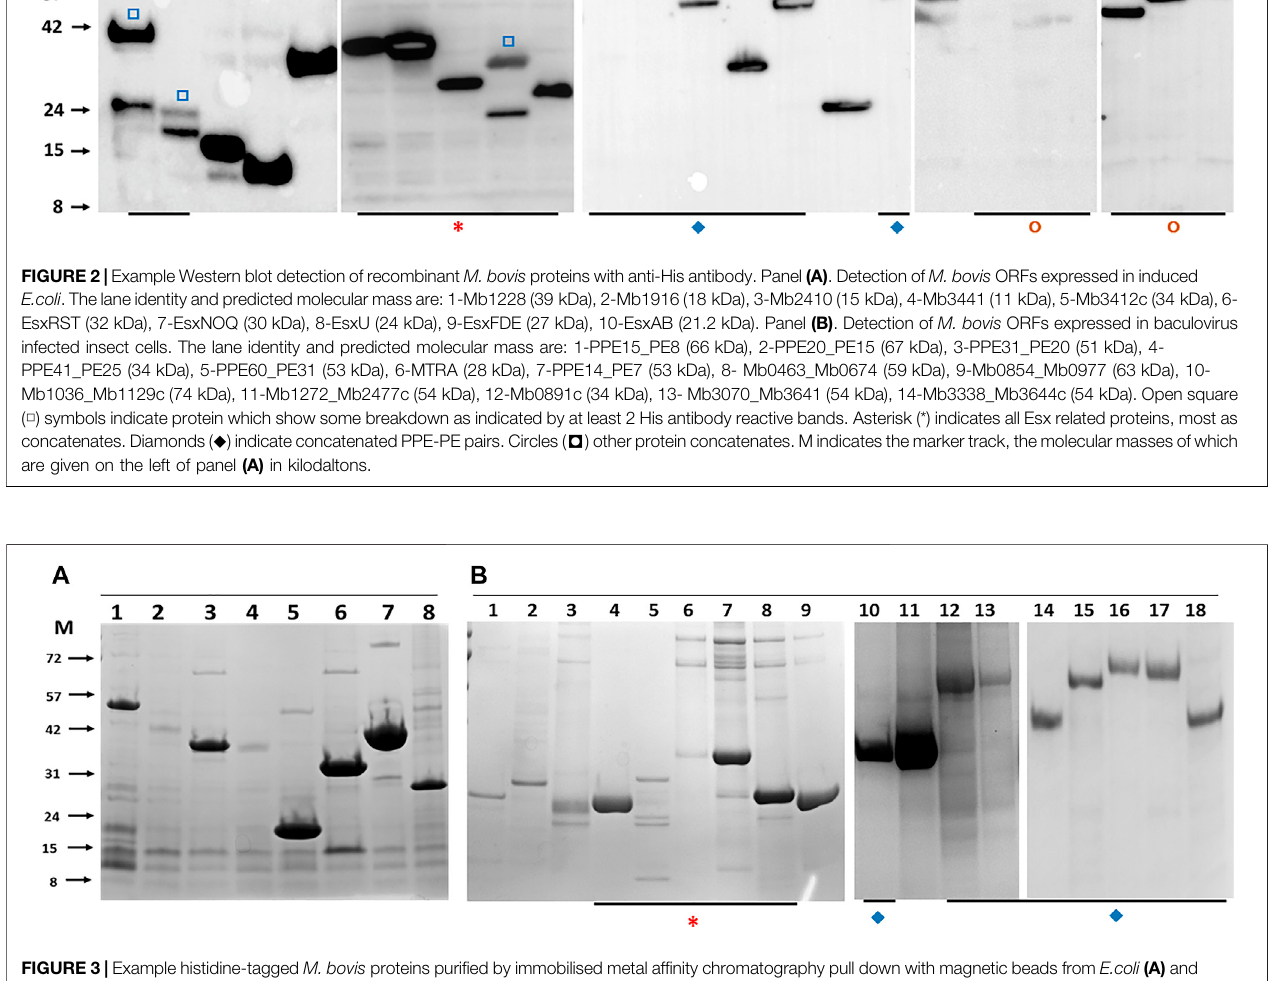
FIGURE 3 | Example histidine-tagged M. bovis proteins puri fi ed by immobilised metal af fi nity chromatography pull down with magnetic beads from E.coli (A) and insect cells (B) . The lane identity and predicted molecular masses are: Panel A, 1-Mb0704 (44 kDa), 2-Mb3070 (37 kDa), 3-Mb2054 (36 kDa), 4-Mb2002_Mb0062 (35 kDa), 5-Mb0671 (17 kDa), 6-Mb0854 (31 kDa), 7- Mb3157c_Mb3743c (37 kDa), 8-Mb0337 (26 kDa). Panel B, 1-PE5_PE32 (19.5 kDa), 2-LpqN (25 kDa), 3-LpqX (22 kDa),4-EsxAB (21.2 kDa),5-EsxFDE(27.3 kDa),6-EsxNOQ (30 kDa), 7-EsxRST (32 kDa), 8-EsxU (24 kDa), 9-Mb0485 (21 kDa), 10-PPE41_PE25 (34 kDa), 11-Mb1228 (39 kDa), 12-PPE69_PE36 (46.6 kDa), 13- PPE68_PE35 (47.5 kDa), 14-PPE14_PE7 (51 kDa), 15-PPE4_PE5 (67 kDa), 16- PPE15_PE8 (66 kDa), 17- PPE20_PE15 (67 kDa), 18-PPE31_PE20 (51 kDa). Asterisk (*) indicates all Esx related proteins, most as concatenates. Diamonds ( ◆ ) indicate concatenated PPE-PE pairs. M indicates the marker track, the molecular masses of which are given on the left of panel (A) in kilodaltons.